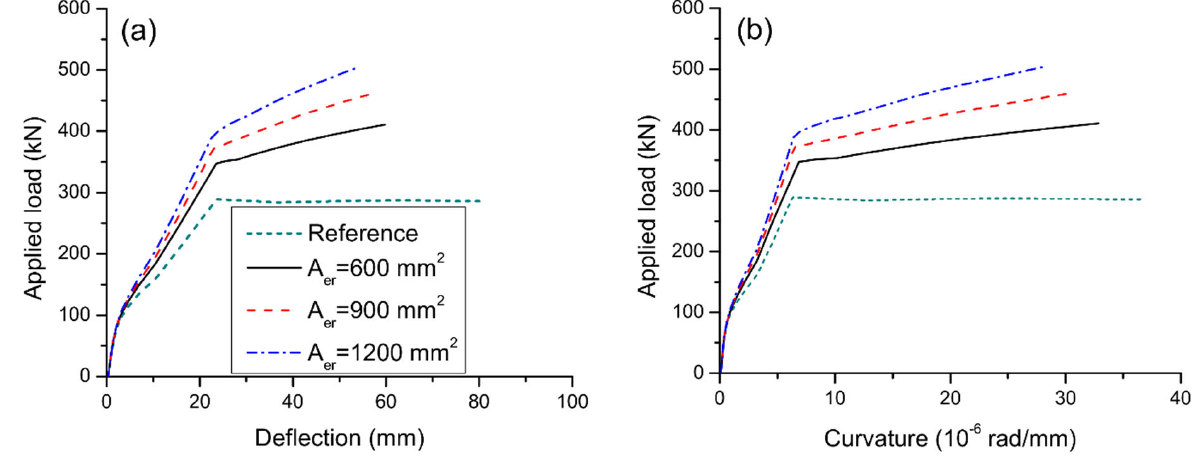
Figure 9. Effect of reinforcement area on the deformation at midspan. ( a ) deflection development; ( b ) curvature development.